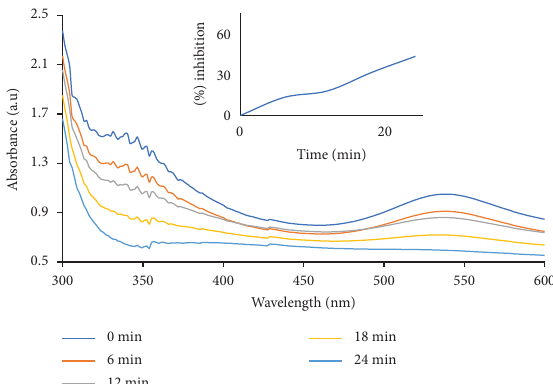
Figure 9: DPPH radical scavenging potential of cellulose/MoS